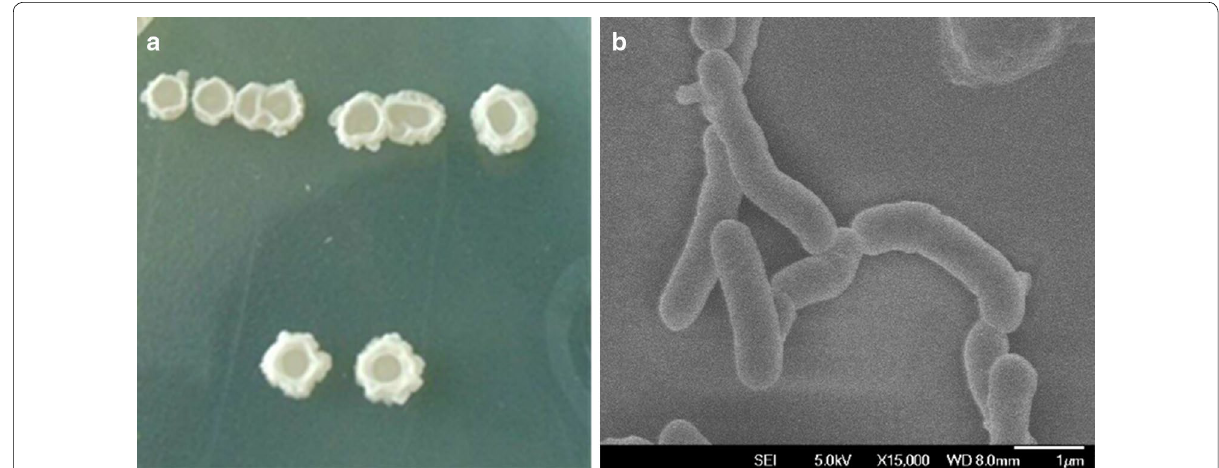
Fig. 1 Colony morphology of strain NCU116-1 ( a ) and its form observed by SEM ( b ). Magnification of SEM is